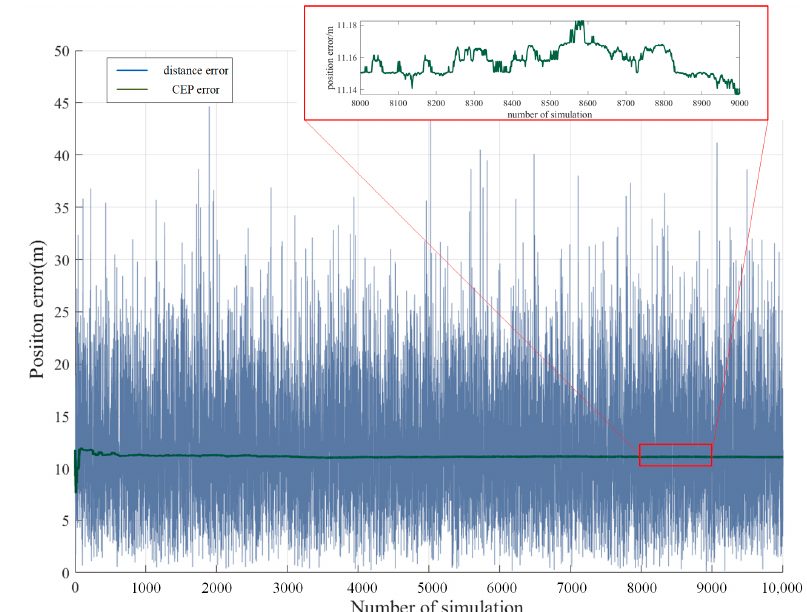
Figure 7. Analysis of geographical position error of aerial remote sensing image.